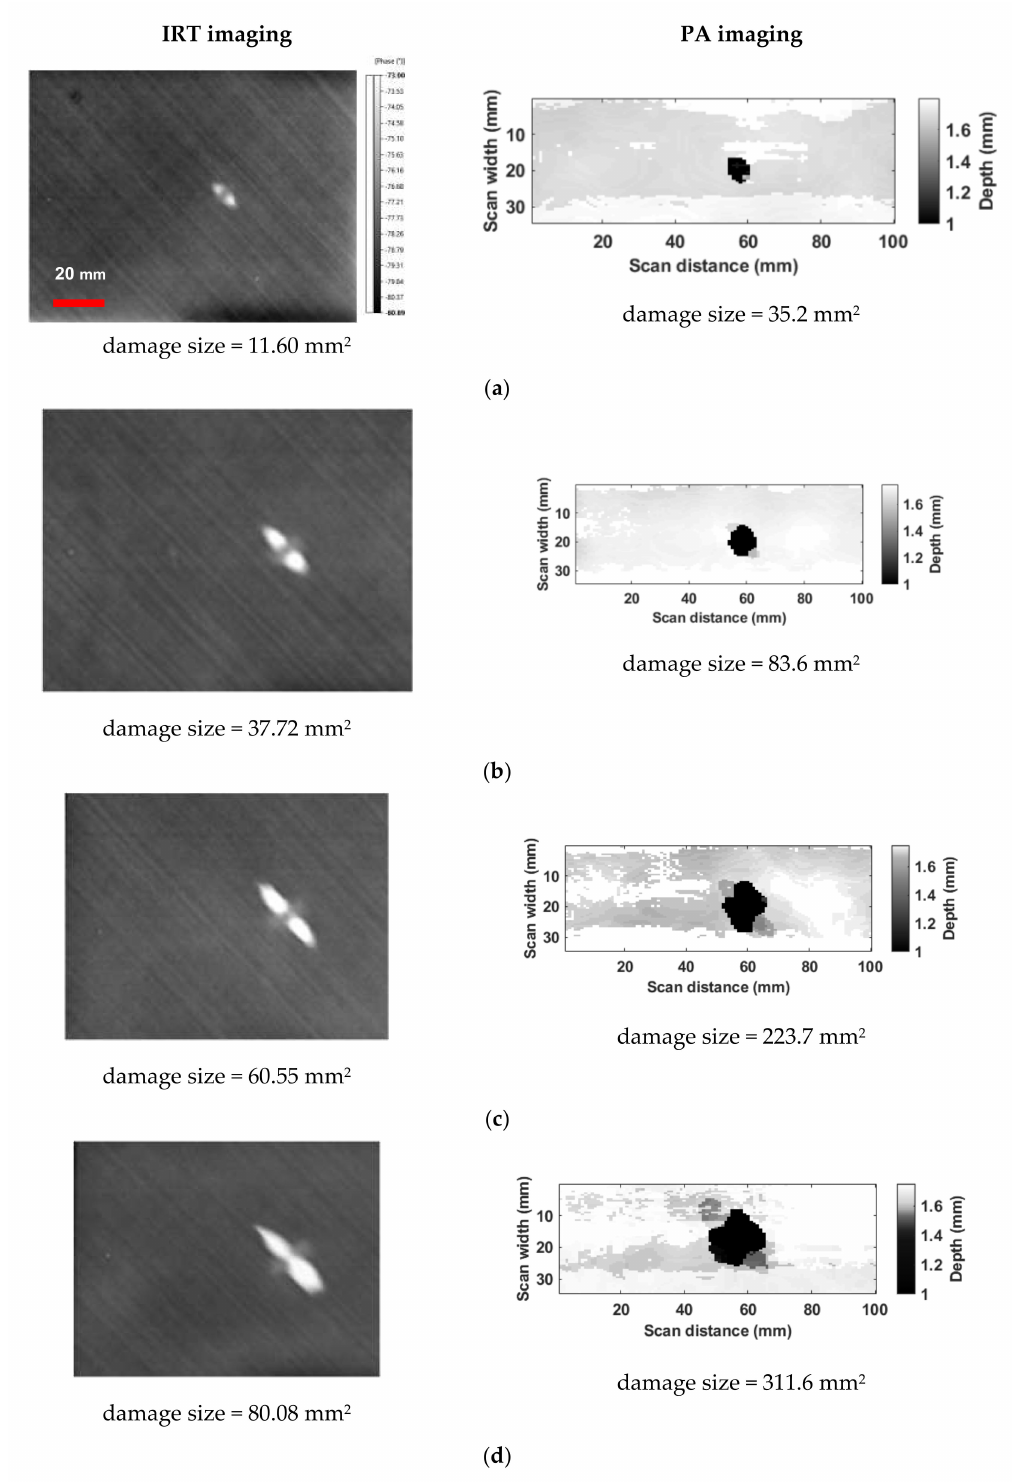
Figure 4. Detection of damage by rapid PPI-LT (thermograms, left column) and subsequent high-resolution characterization by PA imaging (right column) for nine-layer coupons with different impacted energies: ( a ) 2.5 J, ( b ) 4 J, ( c ) 8 J, and ( d ) 12